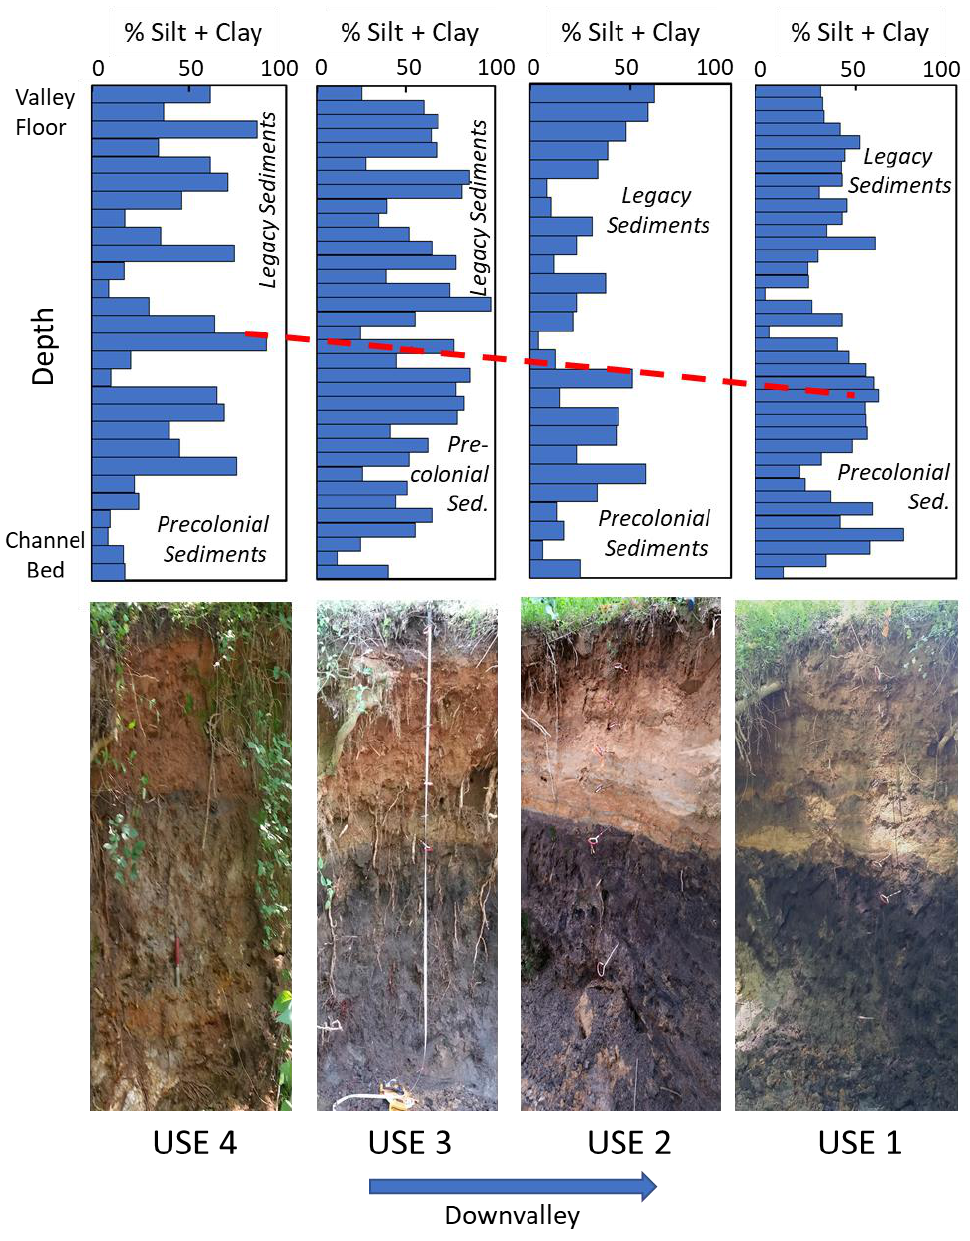
Figure 5. (Upper graphs) Comparison of the vertical variations in the fine sediment content of the precolonial and legacy deposits at the four examined sites; (Bottom) Photographs of the deposits at the four sites. Dashed-red line represents contact between legacy and precolonial sediments. Downvalley correlation of distinct lithostratigraphic deposits can only be conducted at a relatively large (10s of cm) scale.